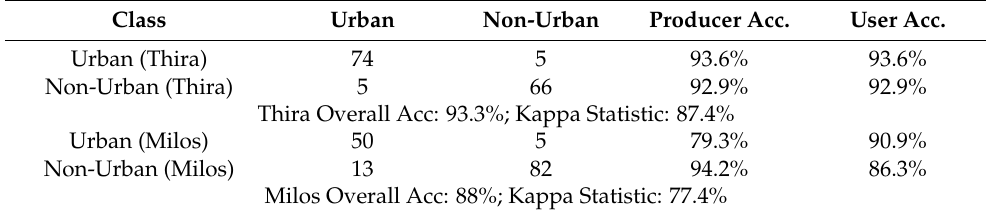
Table 4. Accuracy assessment table for the Thira and Milos classification map (2021). Class Urban Producer